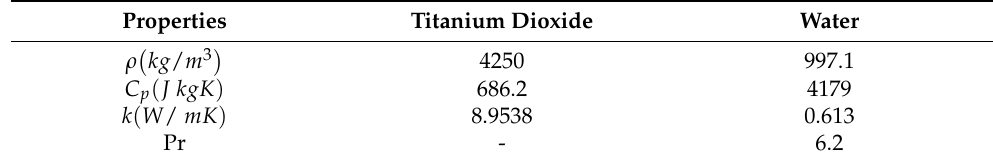
Table 2. Thermo-physical properties of nanomaterial and base fluid.